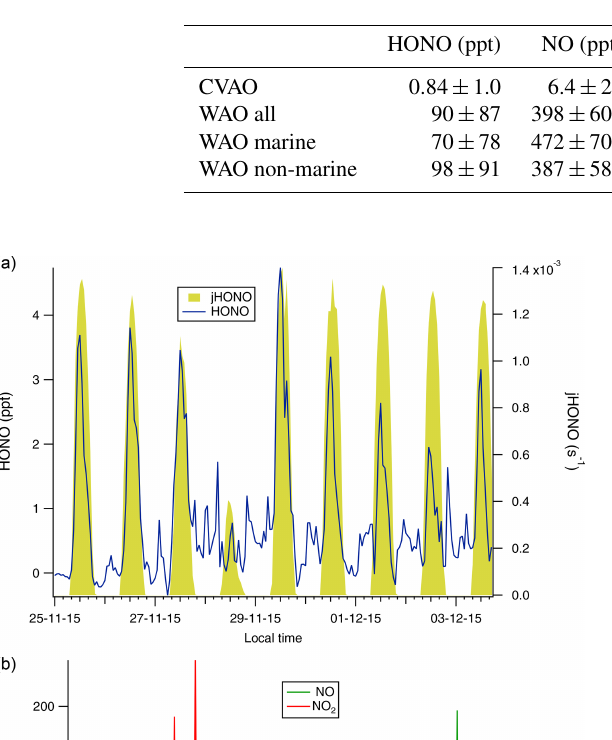
Table 1. Mean mixing ratios of HONO, NO, NO 2 and O 3 at WAO (July 2015) and CVAO (25 November–3 December 2015). Ozone diurnal profiles are provided in the Supplement (Figs. S1 and S2). WAO data including averages over the whole measurement period (“all”) and subdivided into periods when the local wind direction was from the ocean (NW, N, NE: “marine”, ca. 23% of all data) or other sectors (“non- marine”, predominantly SE–SW). Averages correspond to periods for which measurements of all four species were available simultaneously; uncertainty is 1SD of the observed levels. The HONO / NO 2 ratios were determined by linear regression between all data points (Fig. S3 in the Supplement).